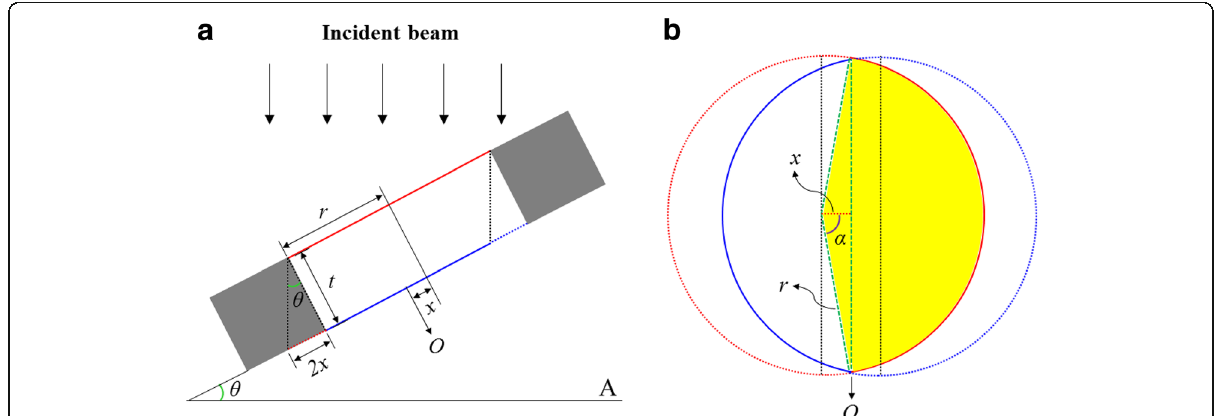
Fig. 1 a Schematic diagram of the tilted hole. b The projected object for the calculation of the projection